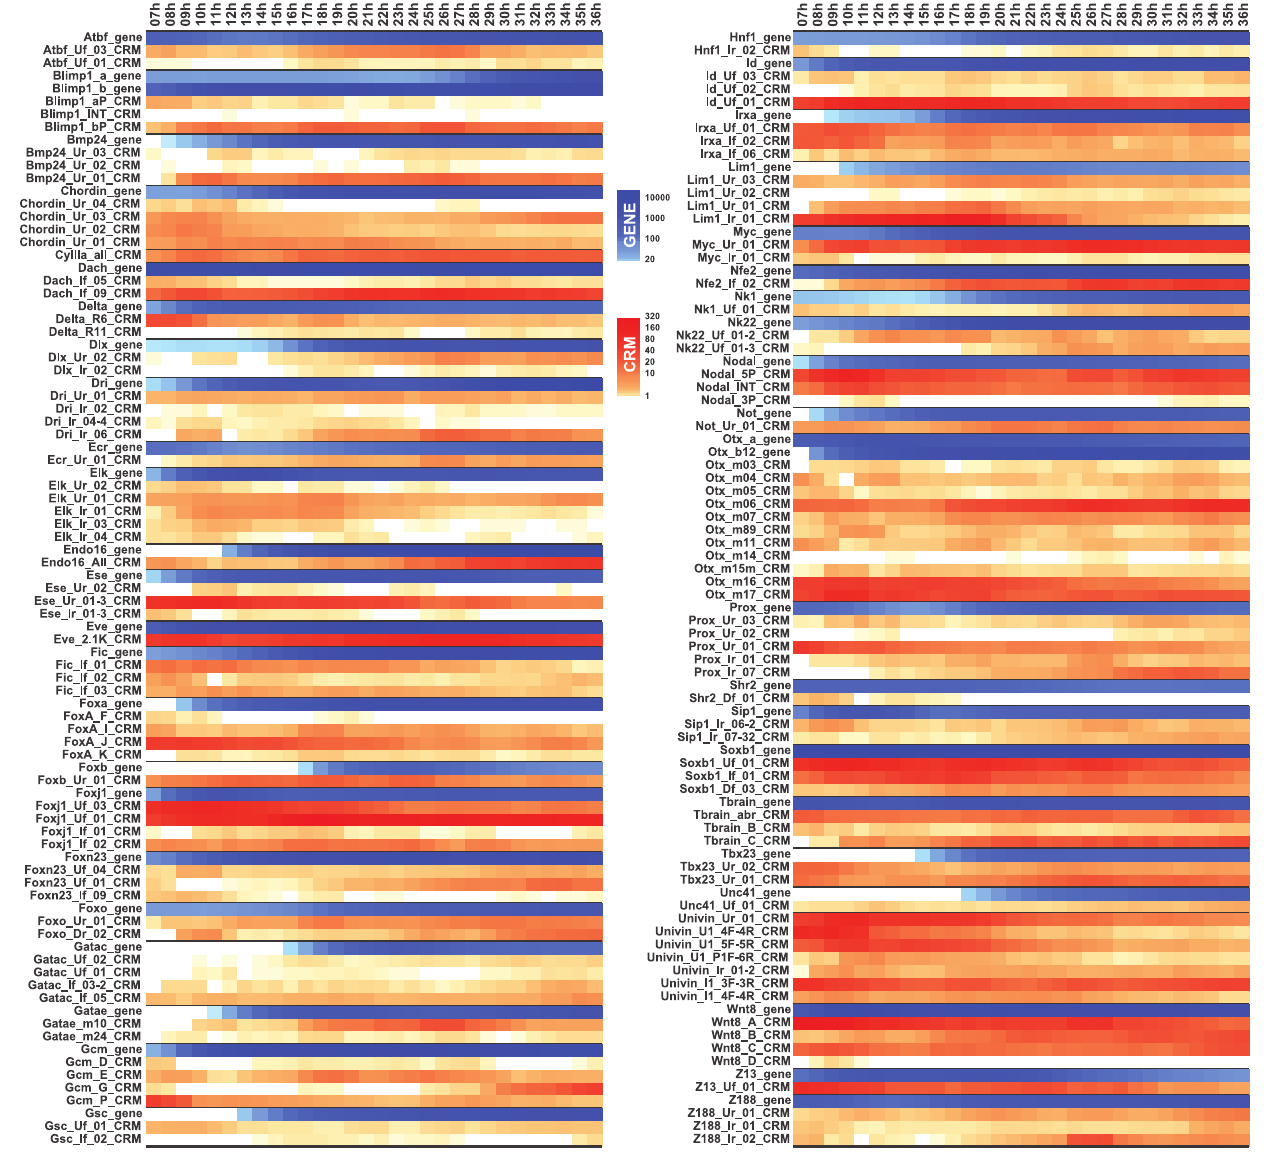
Figure 3. Hourly temporal profiles of CRM activities and gene expressions in developing sea urchin embryos. High resolution temporal profiles of genes and CRMs. Expression levels of the 46 genes (blue) and activities of CRMs (red) from each gene are shown in the order of 5 9 to 3 9 side of the gene. Temporal gene expressions were taken from Materna et al [17]. Scale of color at each time point (h) is proportional to the averages of three adjacent time points, h 2 1, h, and h + 1. Numbers shown on the scale bar indicate the numbers of transcripts per embryo.